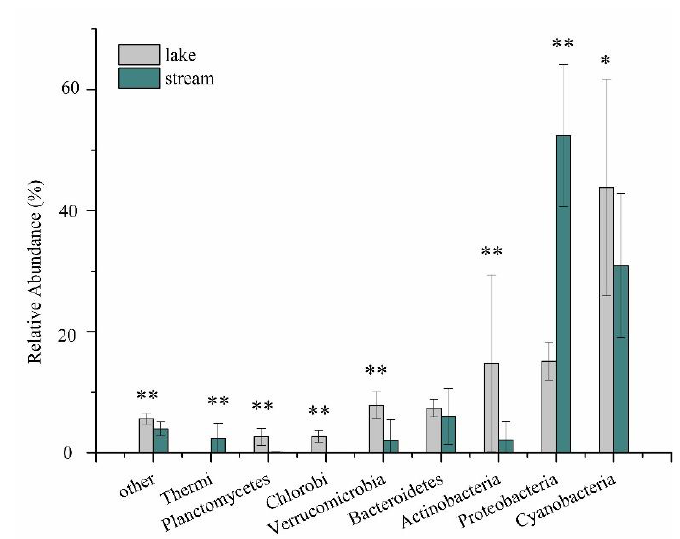
Figure 2. Phyla-level bacterial relative abundances in Erhai Lake and streams. Only phyla with a relative abundance > 1% in either streams or the lake are shown; “other” represents the unsigned operational taxonomic units (OTUs) and the phyla with a relative abundance < 1%. The comparison of lake and streams bacterial abundances was assessed by t -tests. ** indicates statistical significance at p < 0.01 and * indicates p < 0.05.